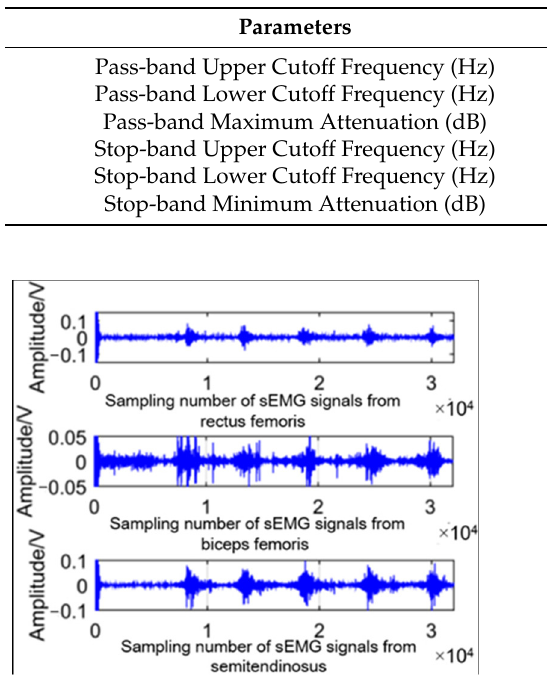
Figure 6. EMG signals in going upstairs procedure after band-pass filter.